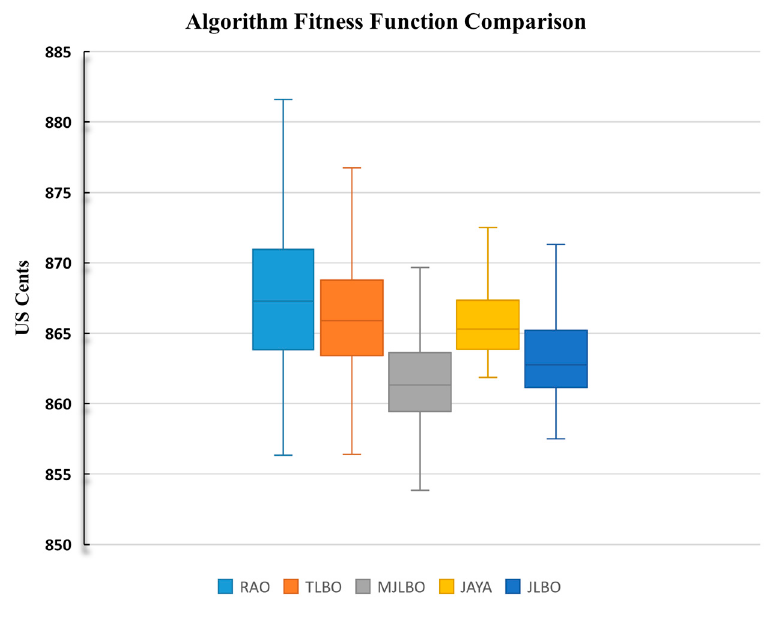
Figure 7. Fitness function spread for 450,000 population iterations. Table 6. Fitness function comparison for 1500 iterations.